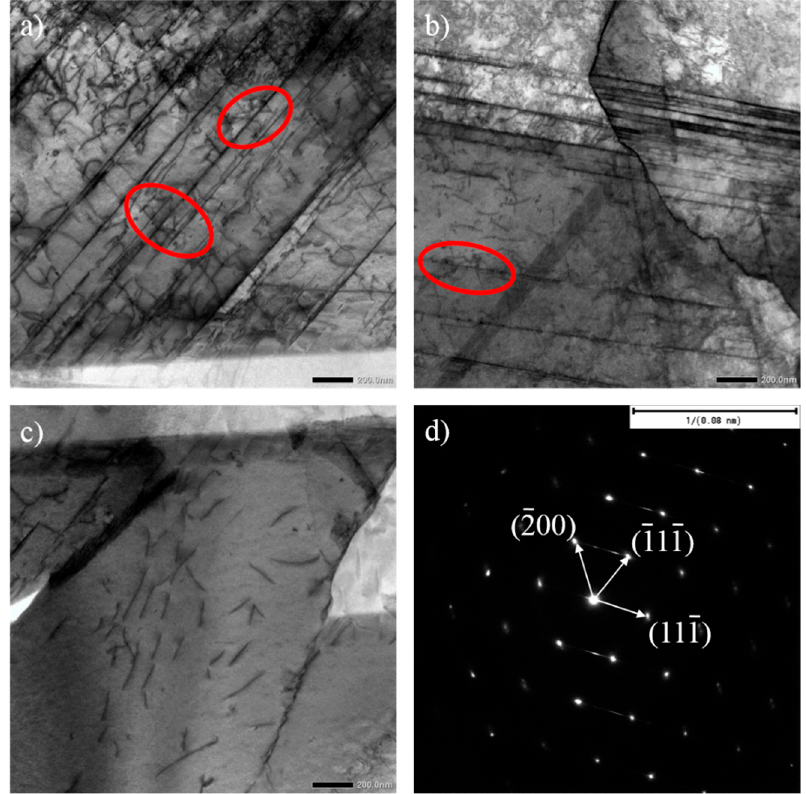
Figure 5. TEM images of the Ti-48Al-2Cr alloy solidified at 5 GPa pressure under different temperatures. ( a ) 1873 K; ( b ) and ( c ) 1973 K; ( d ) SAED of γ phase in ( c ).